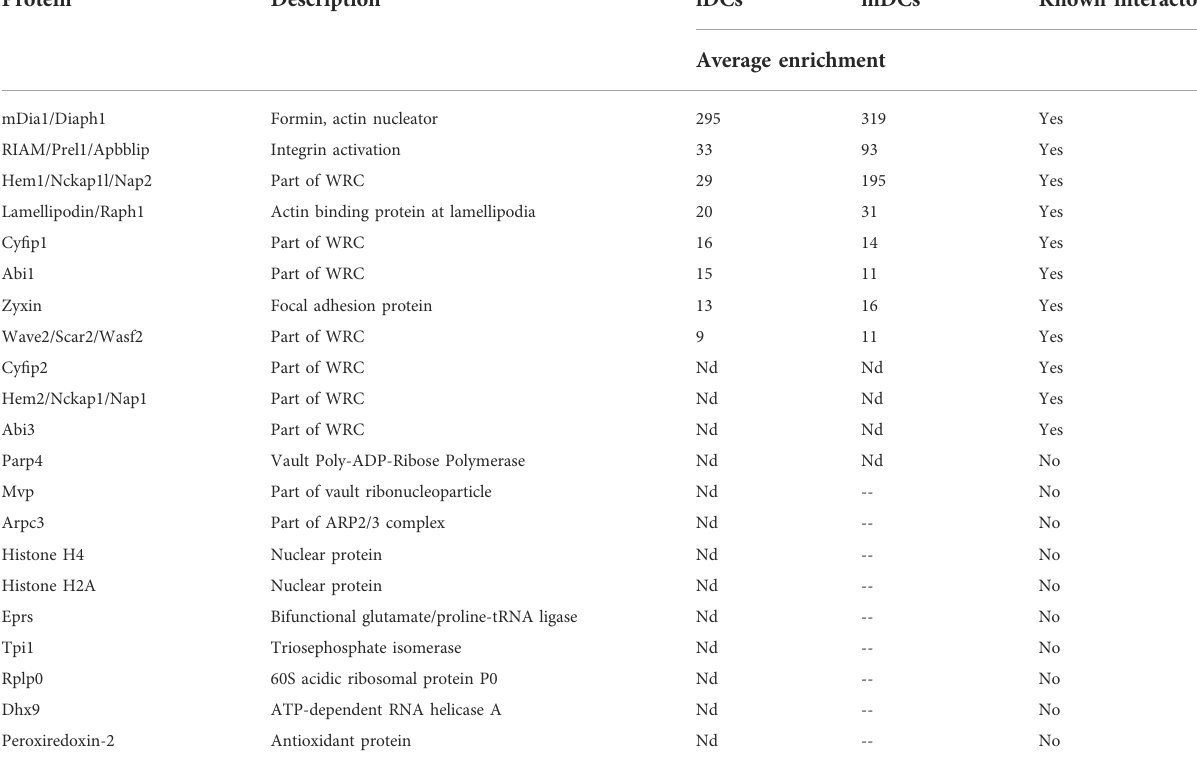
TABLE 2 Hits obtained by mass